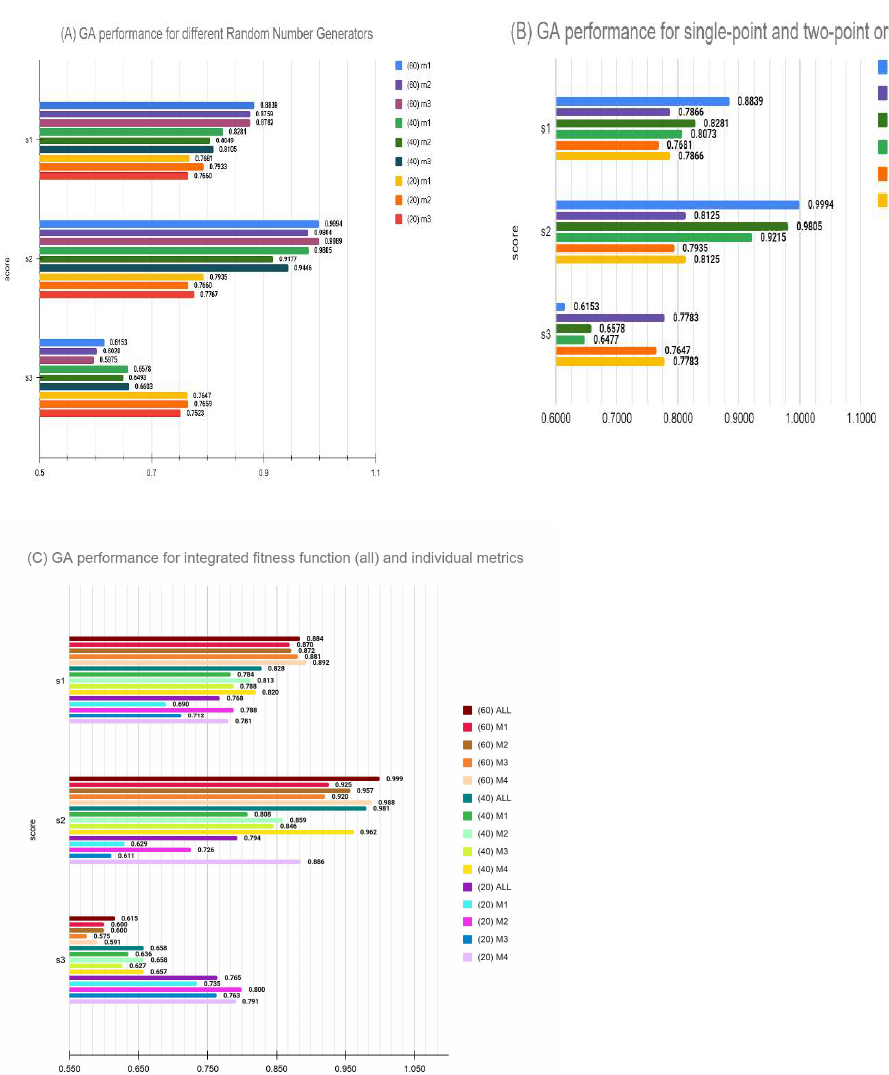
Figure 2. Barplot showing comparison of three Dialogue for Reverse Engineering Assessments and Methods (DREAM) sub-challenge score (s1, s2 and s3) of gene sets generated for ( A ) different random number seeds (rn1, rn2 and rn3). ( B ) Single-point and two-point crossovers. ( C ) Integrated fitness function and each metric individually. Scores generated after bootstrapping 1000 times, and definitions are as provided by DREAM Single Cell Transcriptomics Challenge. These three scores are related to the accuracy of location predicted, correlation of predicted location with expression from reference atlas, variance of predicted location and the extent to which original spatial patterns were reconstructed [37].